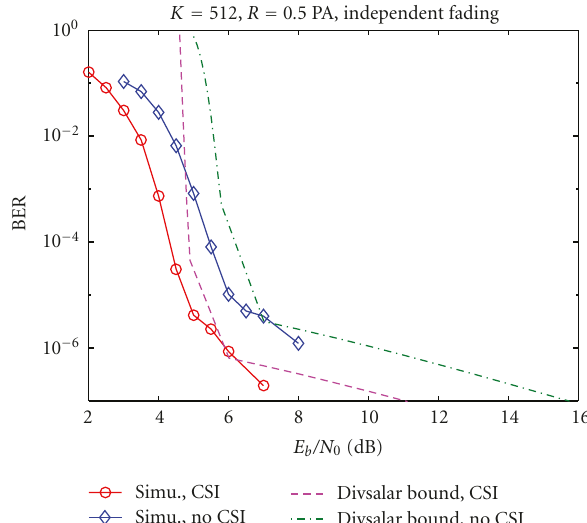
Figure 2: Divsalar simple bounds for R = 0.5 PA